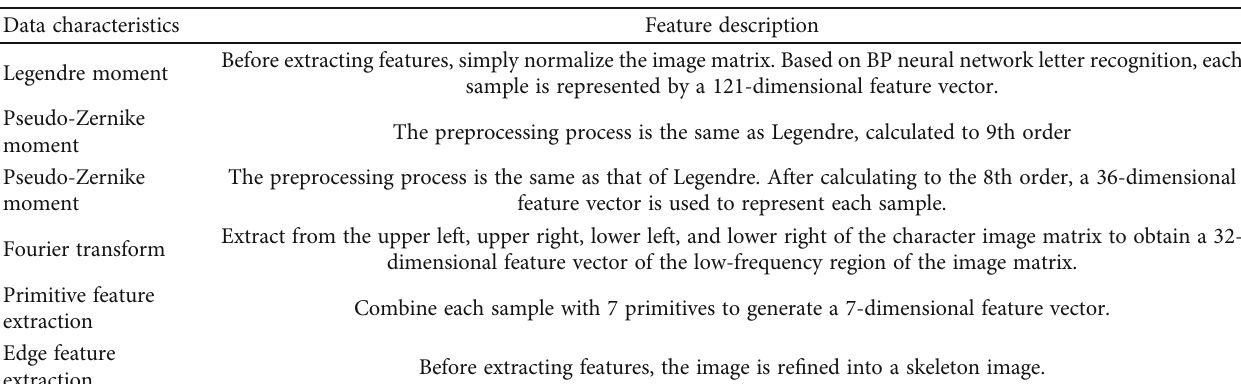
Figure 2: 26 uppercase and lowercase English letter segmentation e ff ects. (a) 26 uppercase and lowercase English letter samples. (b) Grayscale processing. (c) Image enhancement. (d) Image segmentation. (e) Morphological processing. Table 1: Characteristic description of